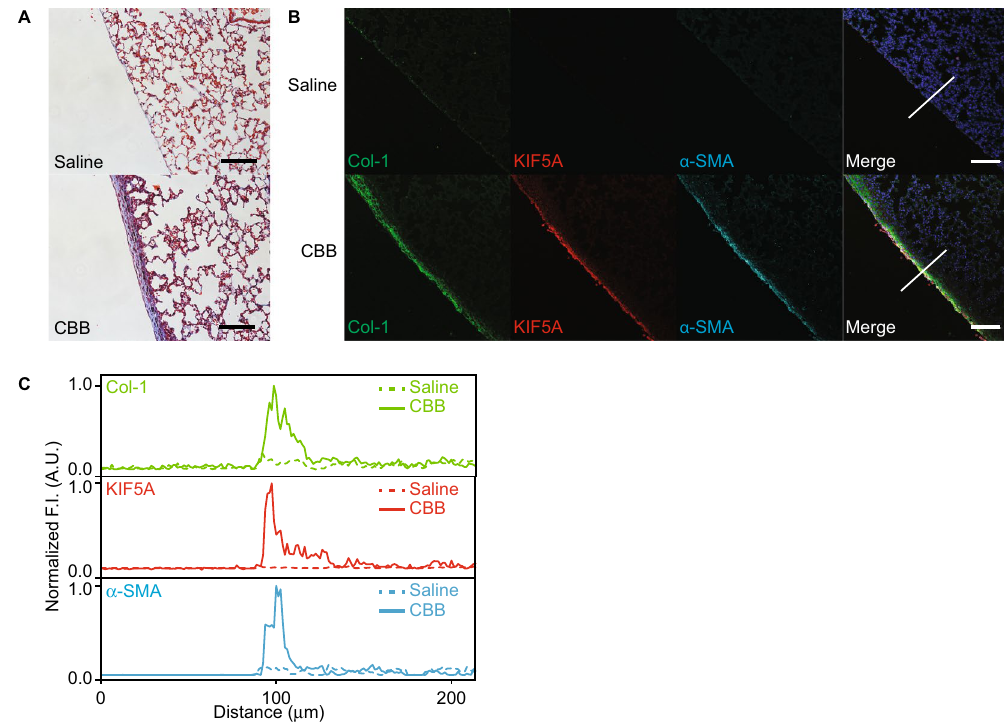
Figure 7. Mice pleural tissue of CBB-treated disease model. ( A ) Trichrome staining of pleural tissue of mice with or without CBB treatment. Scale bar; 100 μ m. ( B ) Immuno-fluorescent staining of pleural tissue of mice with or without CBB treatment. Merge images include blue nucleus signal. Scale bar; 100 μ m. ( C ) Quantitative line profile along white lines of B. F.I., Fluorescent